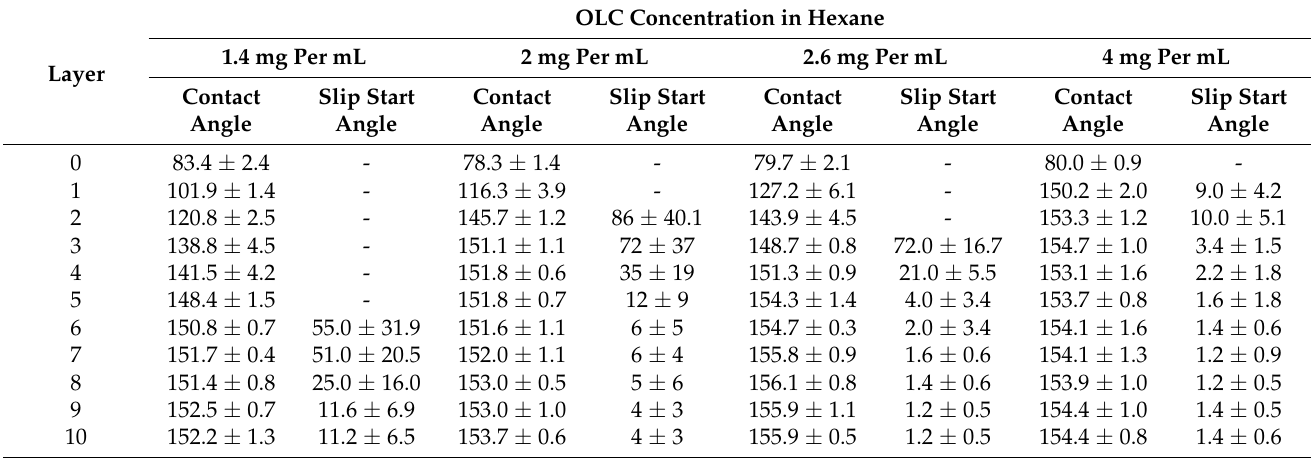
Table 3. Influence of OLC concentration in the solvent on the properties of the coating.